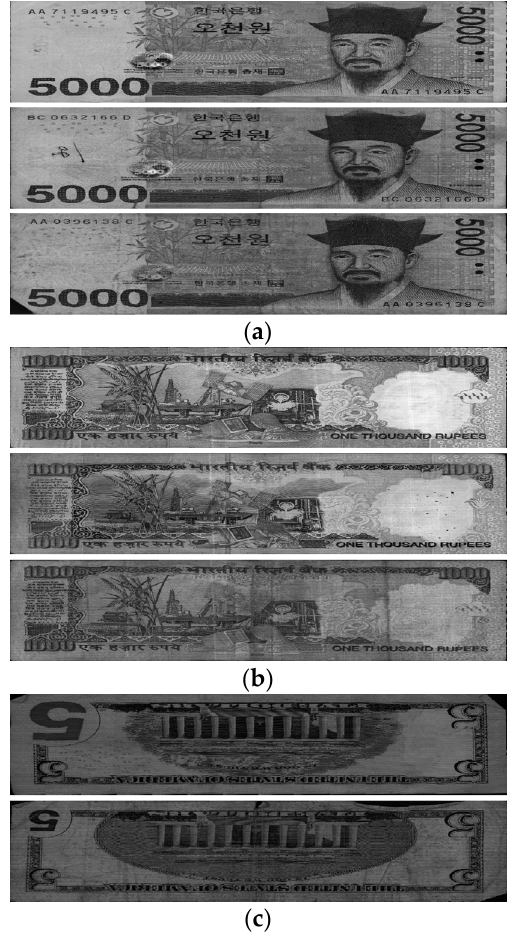
Figure 9. Examples of correctly classified cases by our method of the ( a ) KRW; ( b ) INR; and ( c ) USD datasets. In ( a , b ), upper, middle and lower figures show the cases that are the correctly classified fit, normal, and unfit banknotes, respectively. In ( c ), the upper and lower figures are the correctly recognized fit and unfit banknotes, respectively.